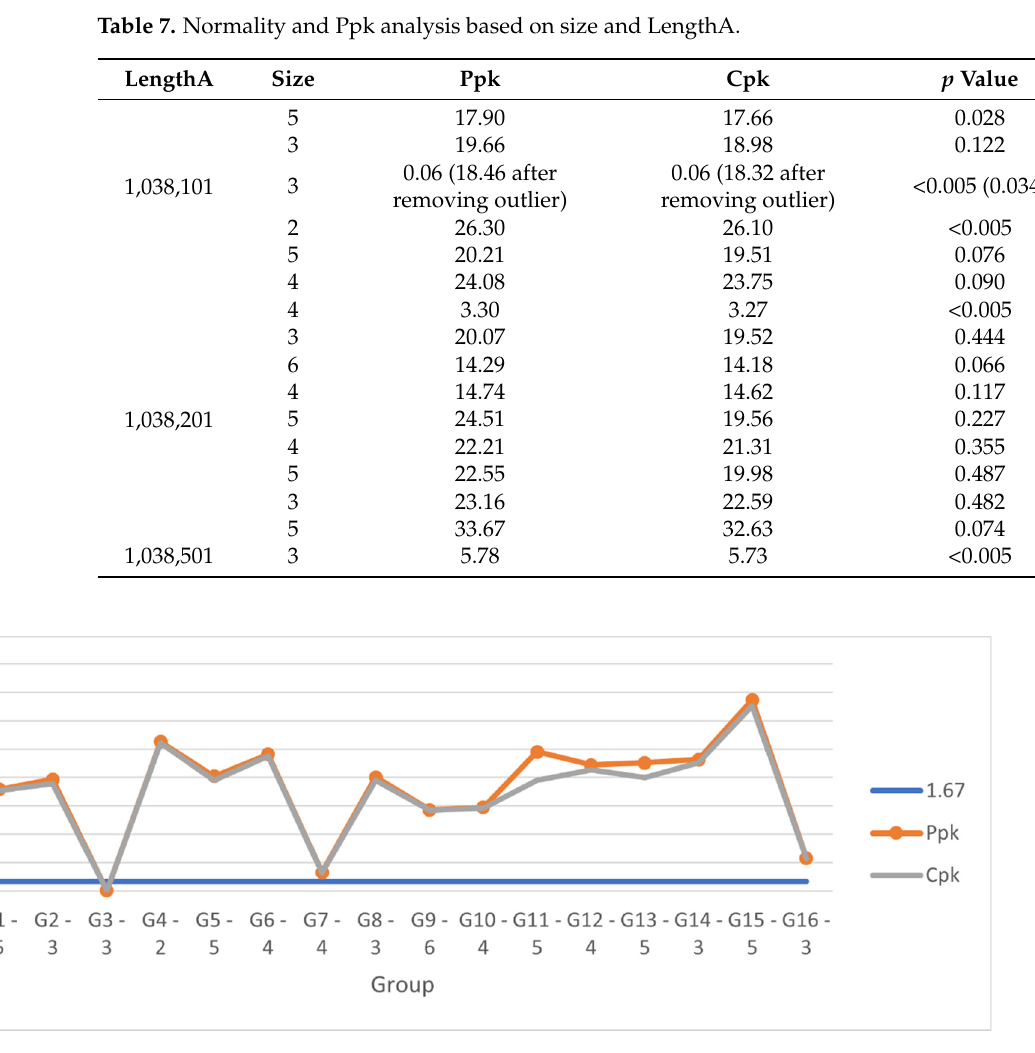
Figure 17. Plot of capability index for all DIMs based on sizes and LengthA.